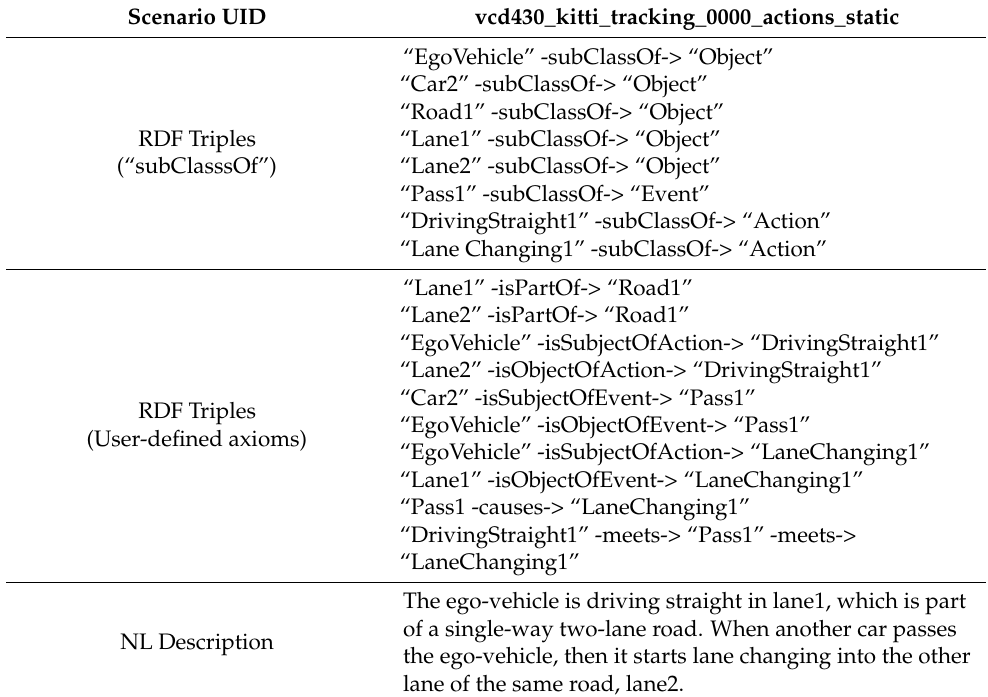
Table 4. RDF triples converted into NL textual description for the KITTI dataset example